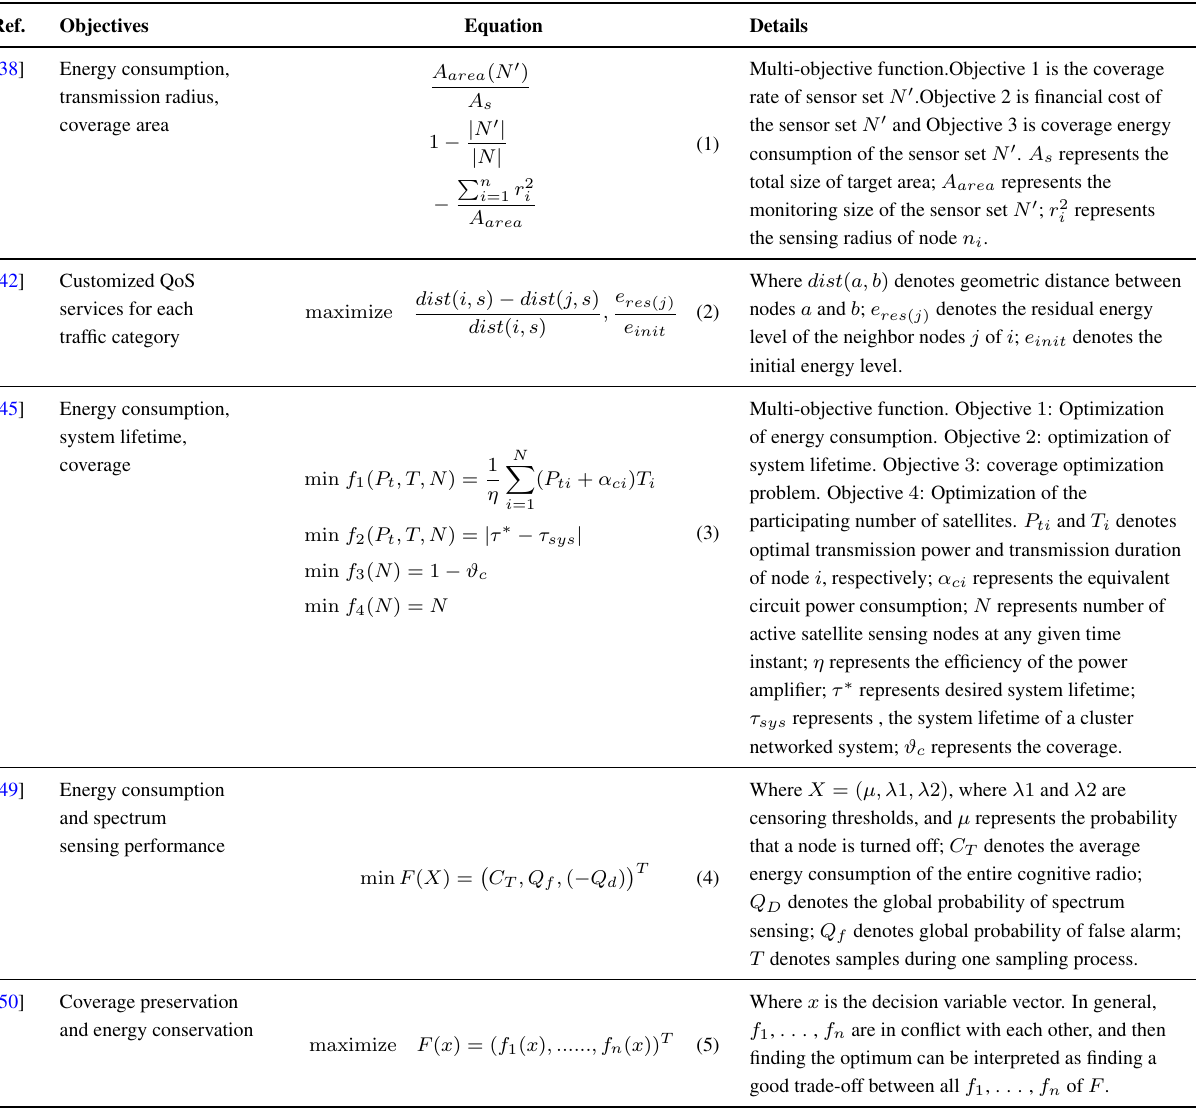
Table 2. Design related objectives in wireless sensor